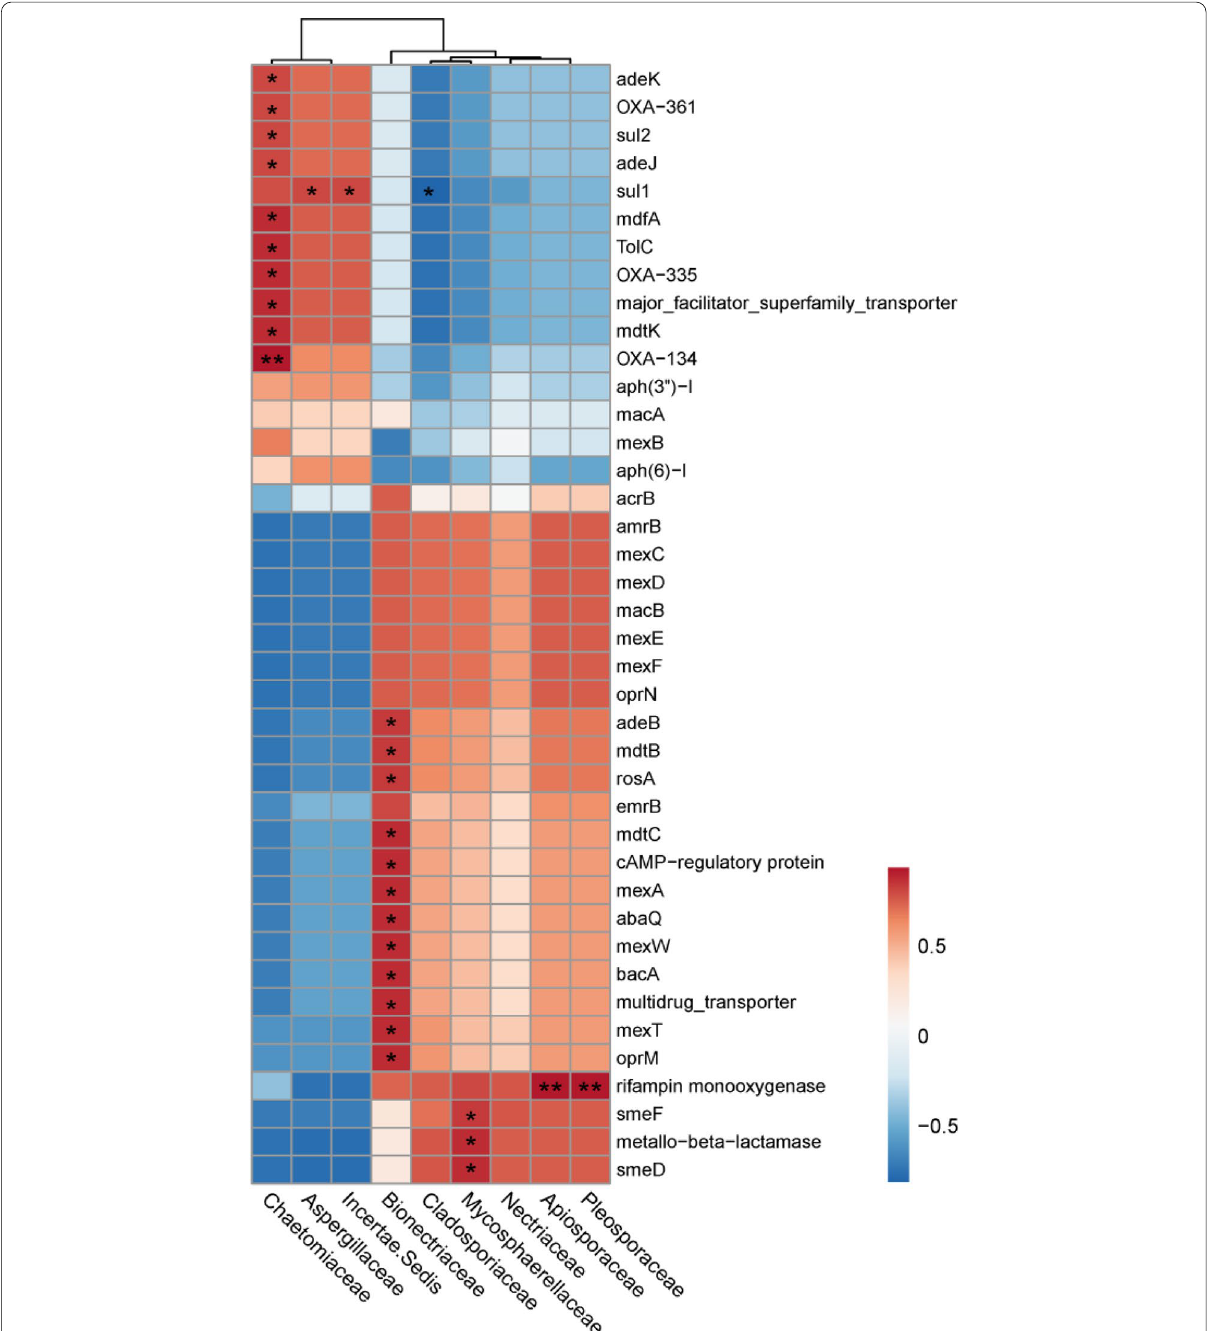
Fig. 6 Spearman correlations between ARG subtypes and the top 9 fungi at the family level. Red and blue indicate positive and negative correlations, respectively. Asterisks mean strong significant correlation (** P < 0.01) and significant correlation (* P < 0.05). The absolute values of the correlation coefficients are all greater than 0.8 in the places marked with